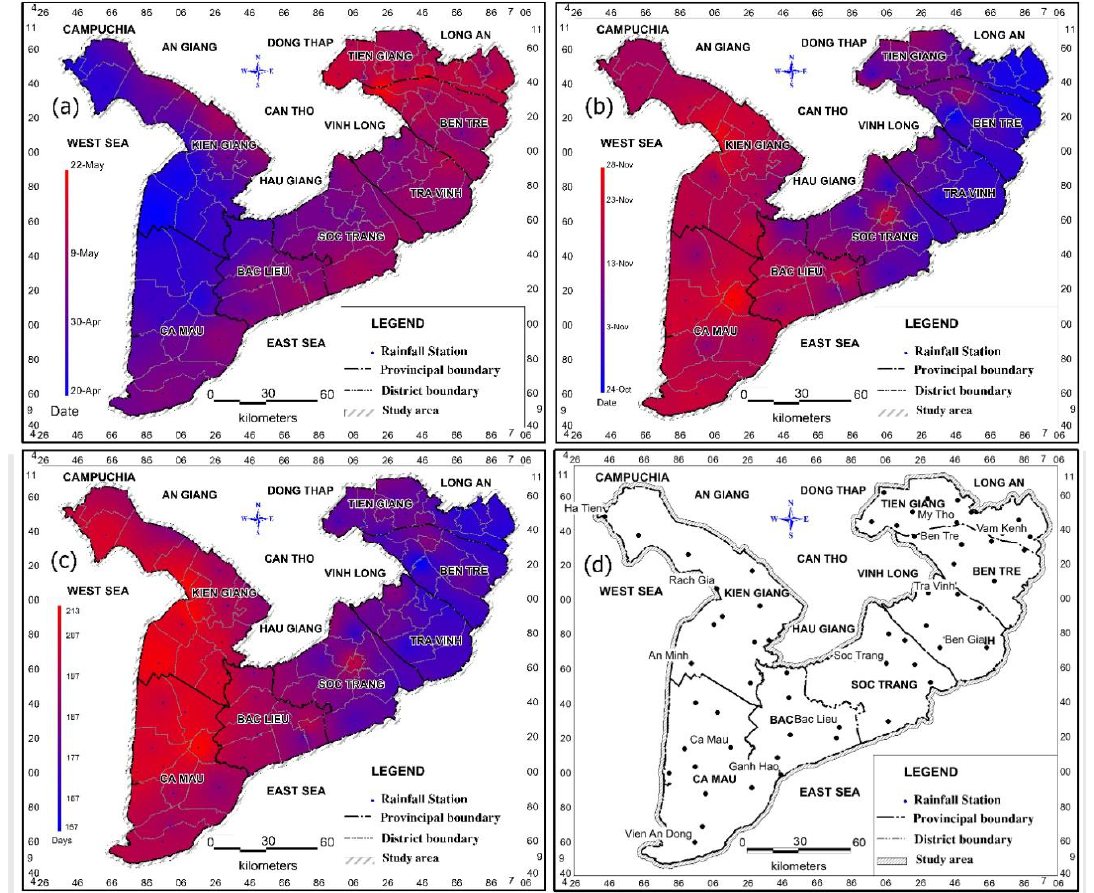
Figure 3. Distribution maps representing the average year (50%) of ( a ) ORD, ( b ) CRD, ( c ) LRS, and ( d ) monitoring stations in the coastal provinces of the Vietnamese Mekong Delta (VMD).